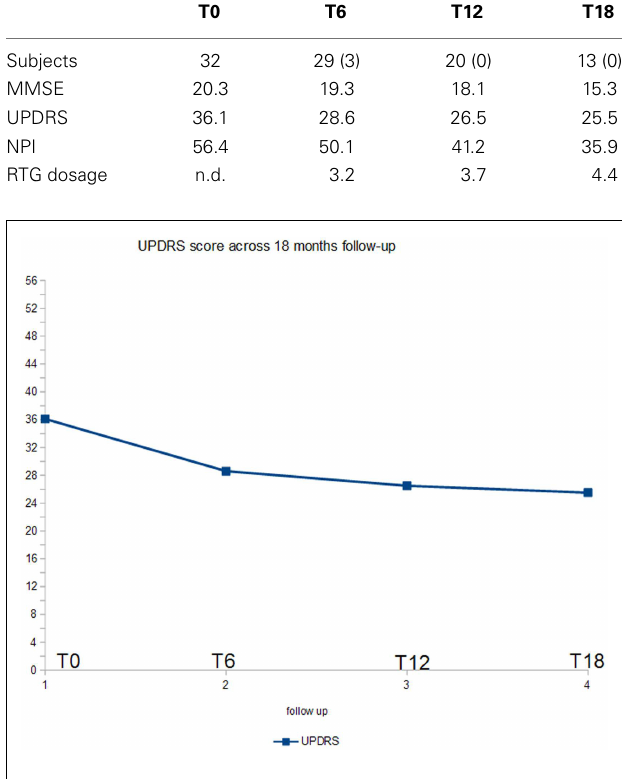
FIGURE 1 |ANOVA results for UPDRS score